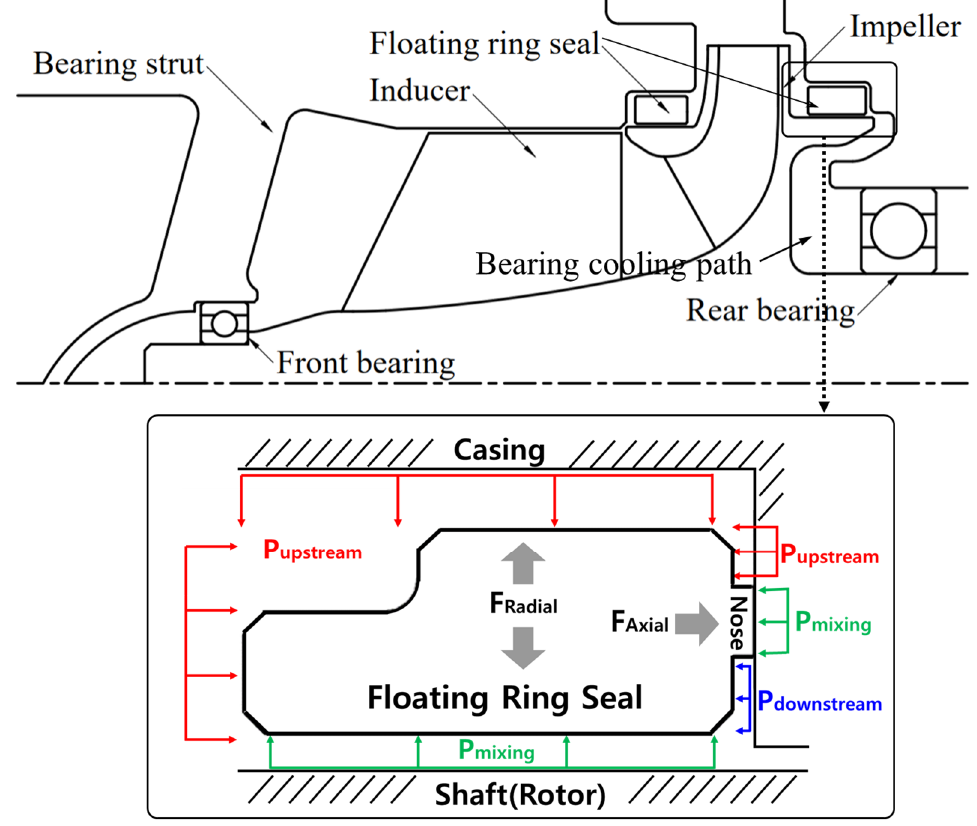
Figure 2. Layout of turbopump with bearing cooling flow path and scheme of floating ring seal.